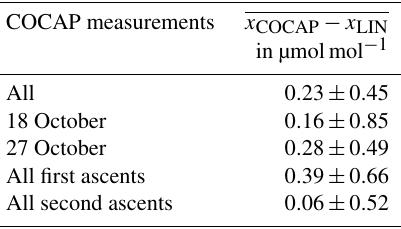
Table 3. Mean of the difference between COCAP’s CO 2 dry air mole fraction measurements x COCAP and the corresponding mea- surements by LIN x LIN ( ± 1 standard error). Subsets of COCAP’s measurements are also analysed.